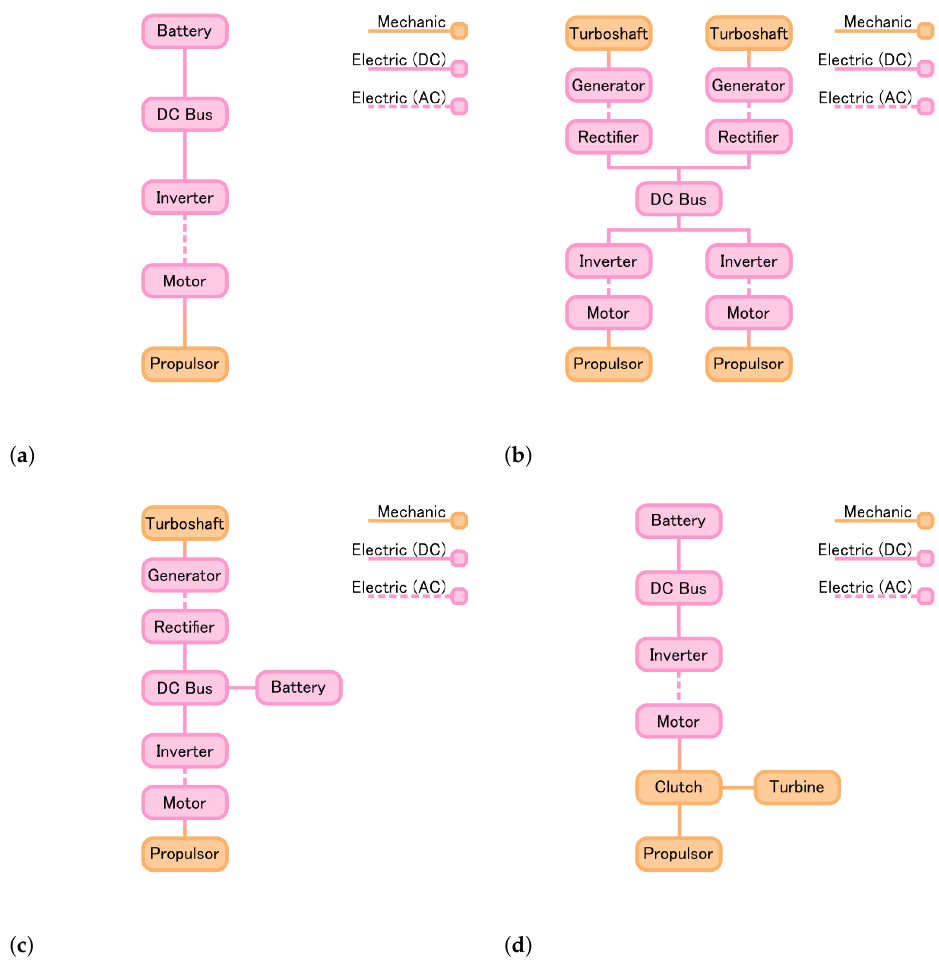
Figure 2. Main topologies for aircraft hybridization. (Adapted from [18]). ( a ) All Electric; ( b ) Twin Tur- boelectric; ( c ) Hybrid Series; ( d ) Hybrid Parallel.